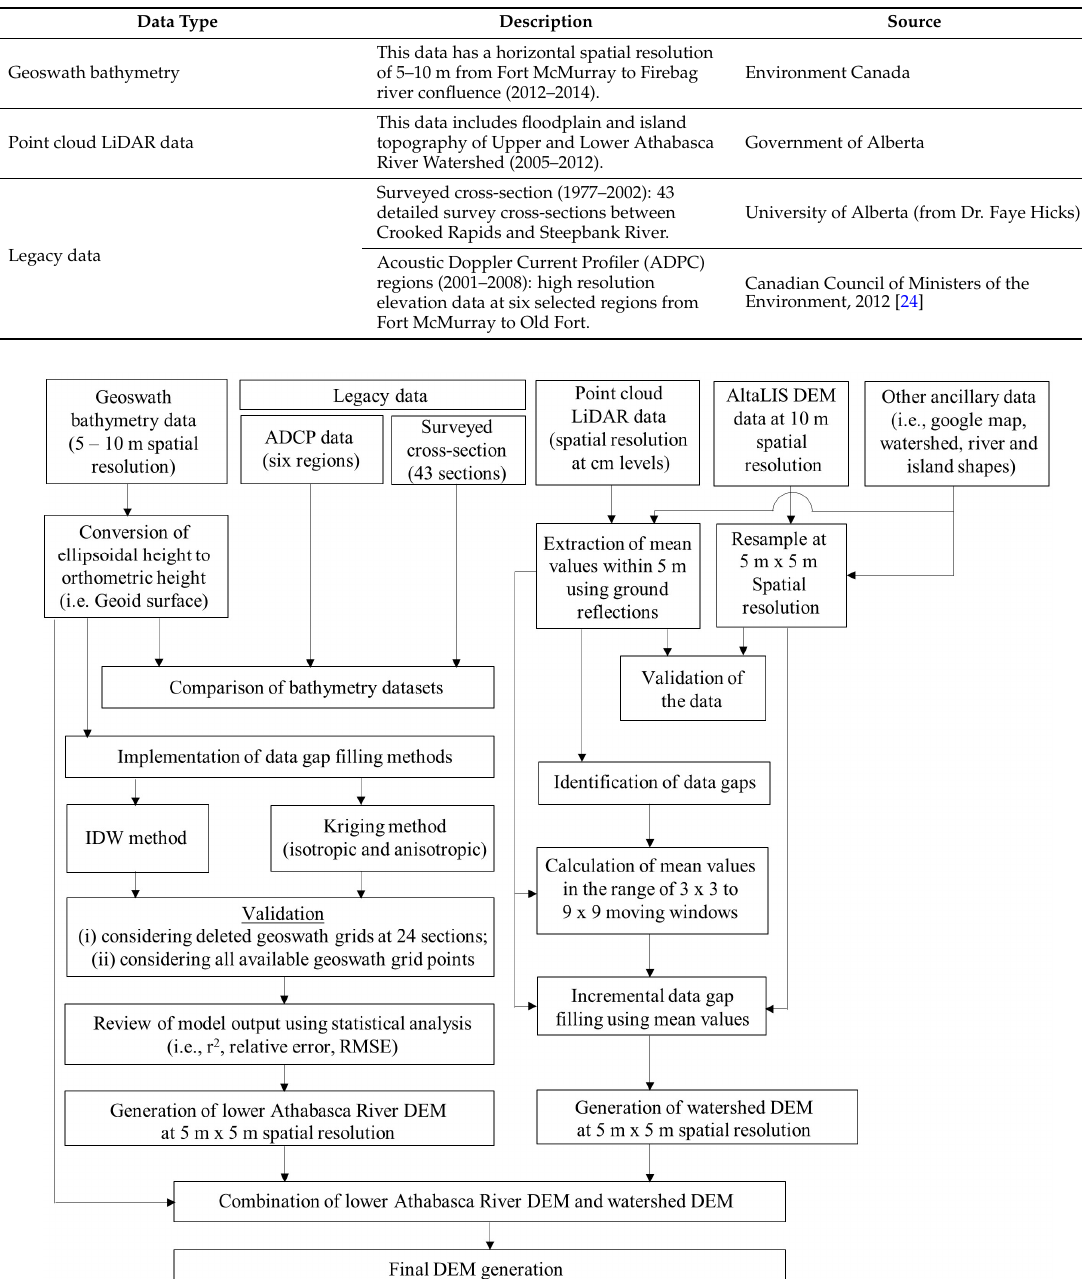
Table 1. Brief description of the primary data used in the current study.